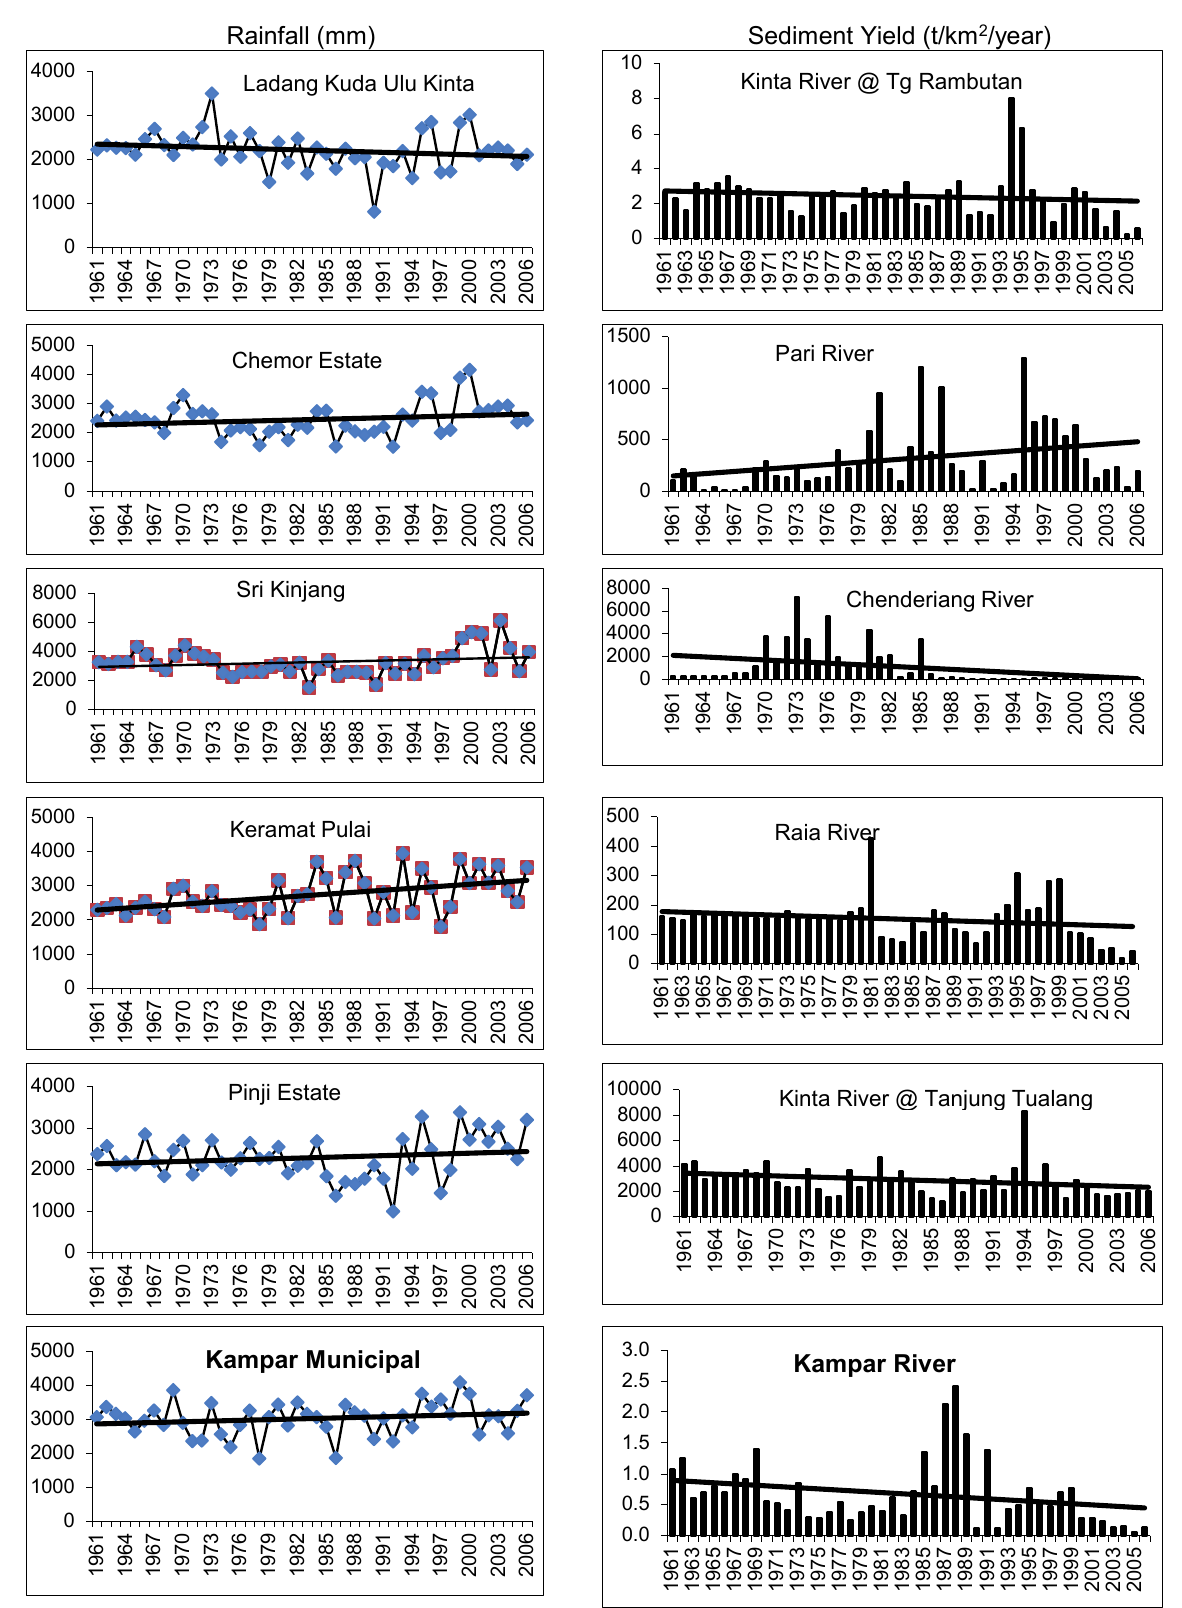
Fig. 2 Long-term trends of rainfall and sediment yield of major tributaries of the Kinta River catchment. Continued on next